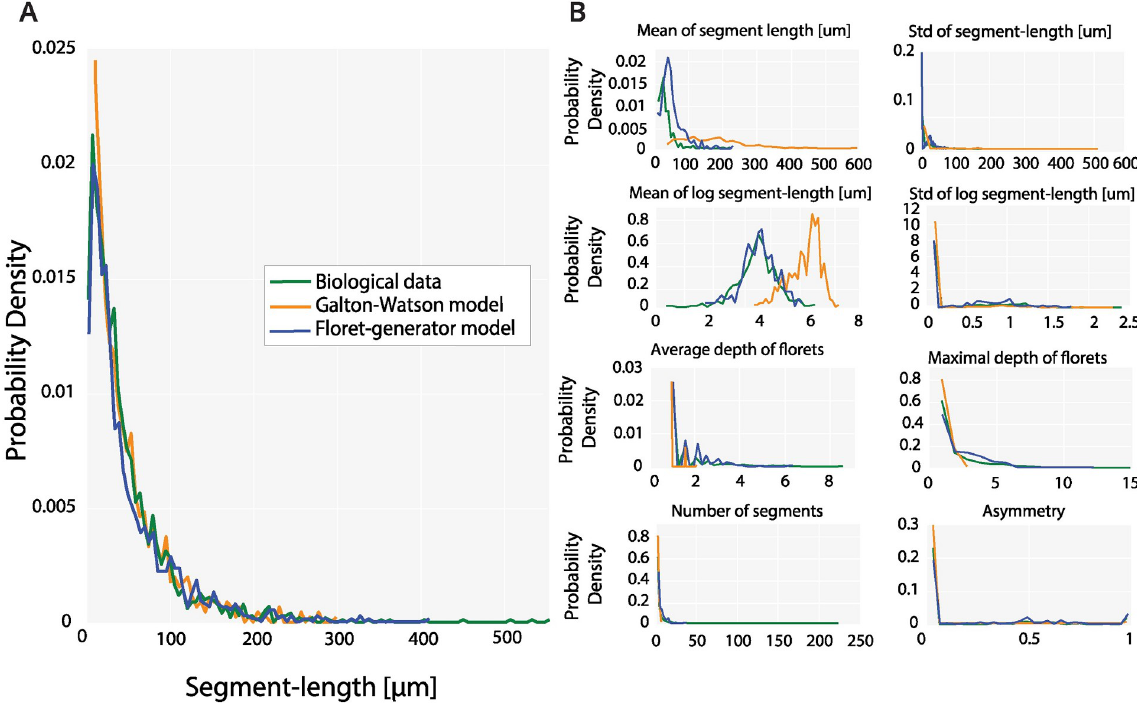
Fig 4. Comparison of generated and biological segment-length distributions and individual statistics. (A) The best generated run from the Galton-Watson model displays a rather high Jensen-Shannon divergence (0.026). This can be explained by the model’s failure to recreate the lack of short segments, and the tail of the biological data. The null-hypothesis of equality is rejected by a two-sample Kolmogorov-Smirnov test (D 2059,1724 = 0.0621, p = 0.0083). The divergence between the segment-length distribution of the floret-generator and the biological data is lower (Jensen-Shannon divergence of 0.011), indicating a good overall fit. As can be seen, the generated segment-length distribution matches peak as well as tail of the biological segment-length distribution. The equality of these two distributions is underlined by a two-sample Kolmogorov- Smirnov test (D 2059,1678 = 0.0302, p > 0.3). (B) Comparison of the generated and biological individual statistics. The biological florets display a high variability with respect to asymmetry and segment-lengths. The lack of the short segment cannot be recreated by the Galton-Watson distribution. Accordingly, the generated segment-lengths do not match the biological data as adequately as the floret-generator is capable of. Indeed, with the exception of the asymmetry distribution, the two-sample Kolmogorov-Smirnov rejects the null-hypothesis of equality for all individual distributions (D 426,500 = 0.1182, p < 0.002). The results of the floret-generator, however, capture the fraction of trivial florets which are completely symmetric and have depth one. Concurrently, the generated florets are also reproducing the entire ranges of the